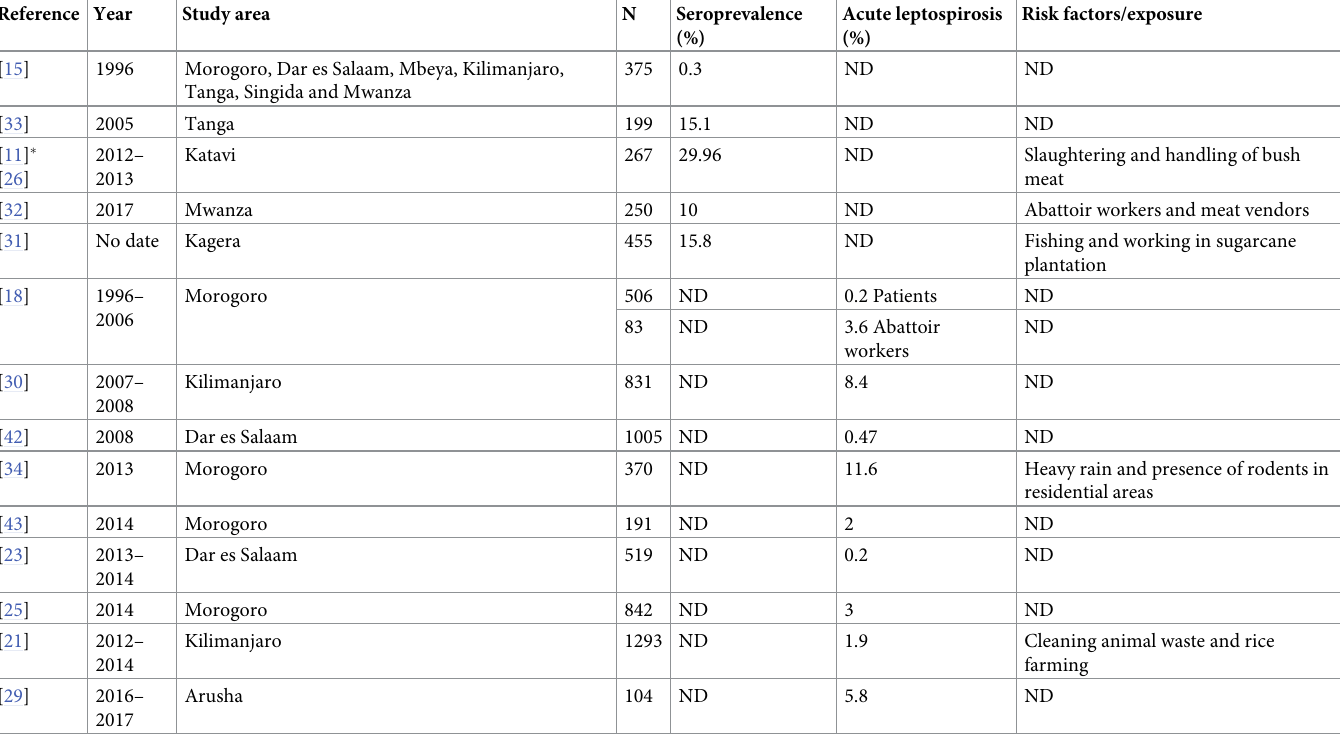
ND: not described � Studies used the same